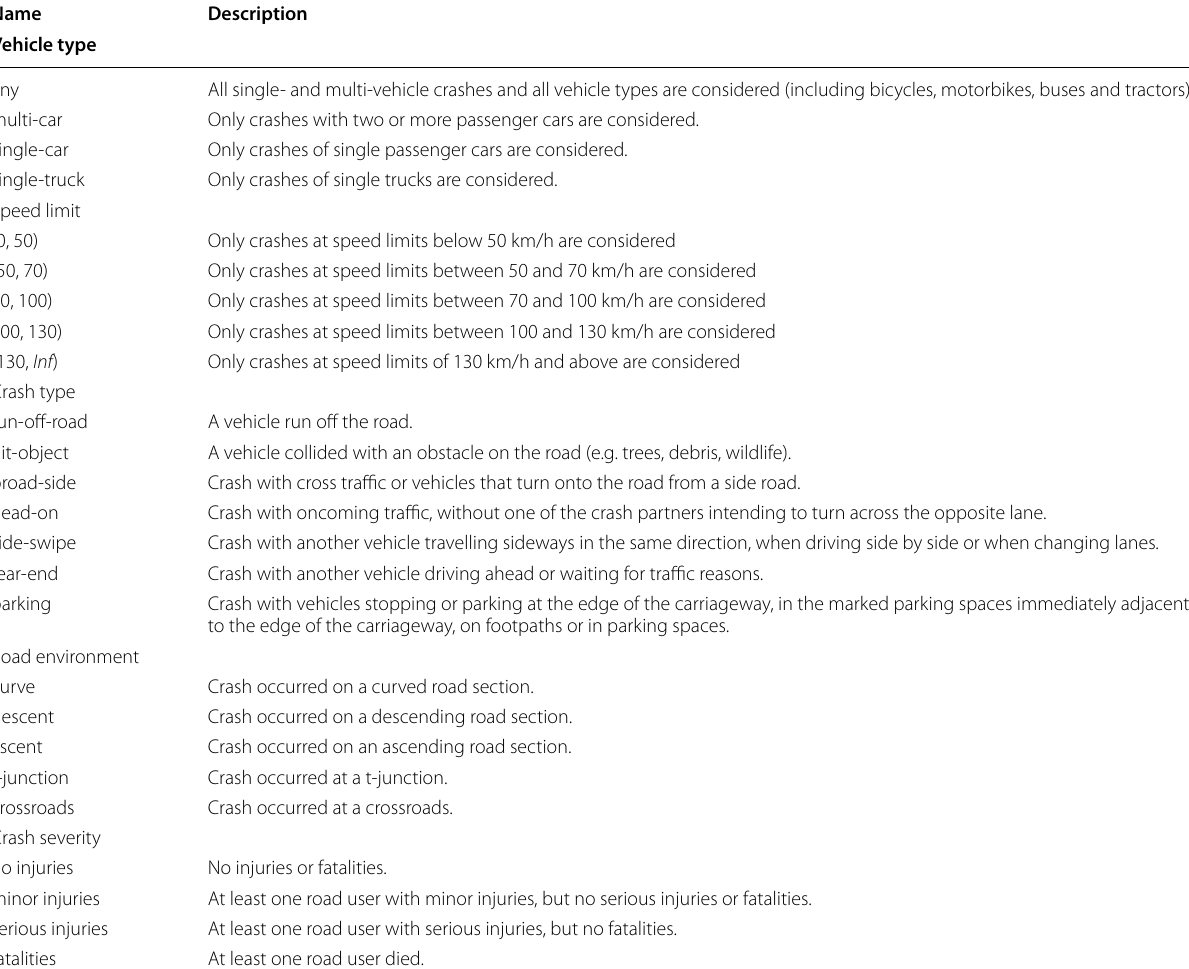
Table 1 Description of crash characteristics used to create the dependent variables of the generalized additive